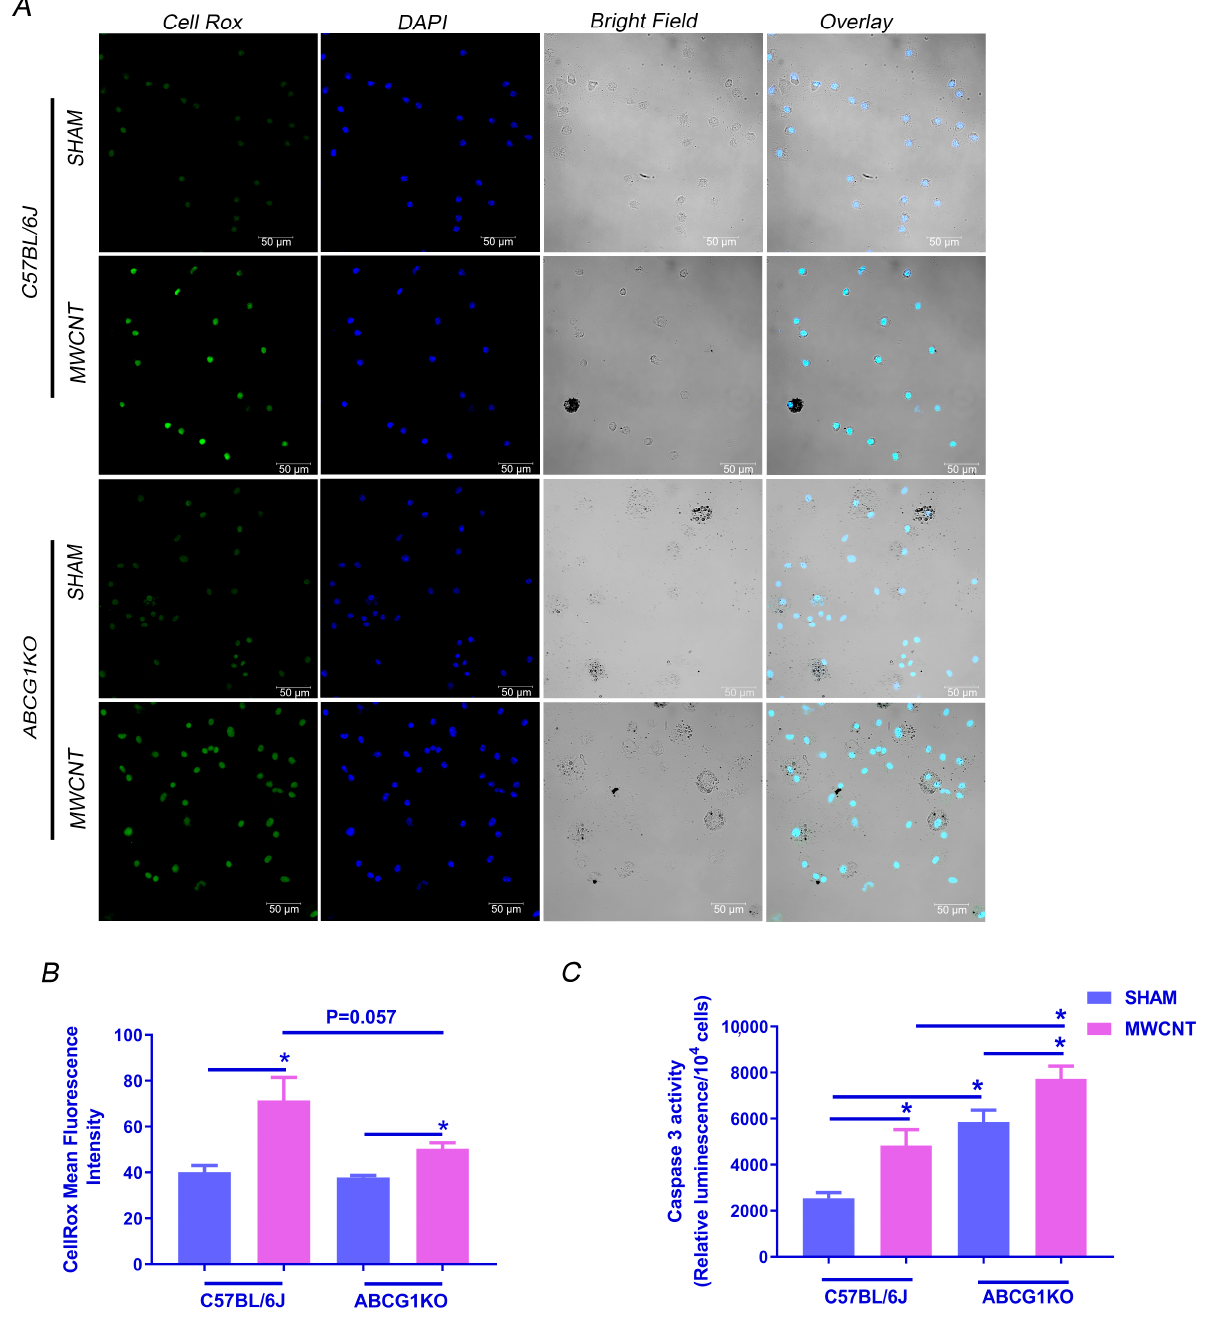
Figure 2. Myeloid ABCG1 deficiency promotes MWCNT-induced apoptosis in BAL cells. ( A ) MWCNT instillation increases oxidative stress in BAL cells of C57BL/6J and ABCG1 KO. Cytospins of BAL cells from C57BL/6J and ABCG1 KO mice either sham or MWCNT instilled were stained with CellRox green and nuclear stain, DAPI (blue). Scale bars: 50 µ m. ( B ) Mean Fluorescence intensity was measured in 18 random fields per one cytospin for each mouse using Zen software (blue edition). ( C ) Measurement of Caspase 3/7 activity in BAL cells using Caspase-Glo 3/7 Assay and quantification of relative luminescence in 10 4 cells. (* p ≤ 0.05, N ≥ 3).